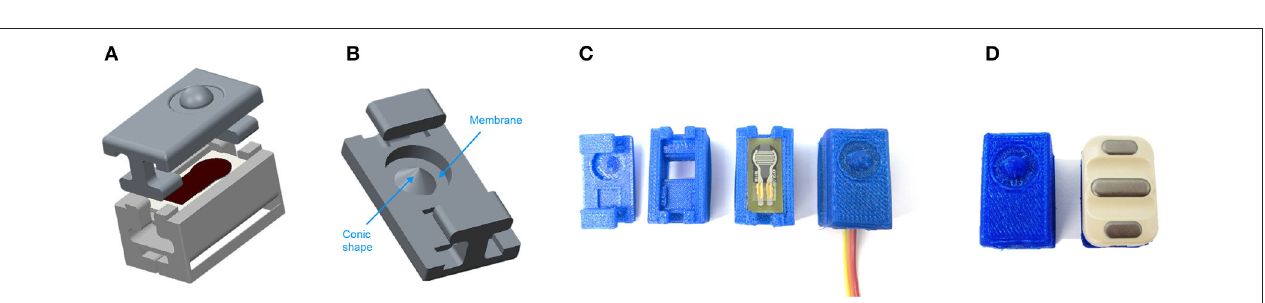
FIGURE 2 | (Left) The amplification circuit for the FSR. (Right) The FSR sensor’s PCB.